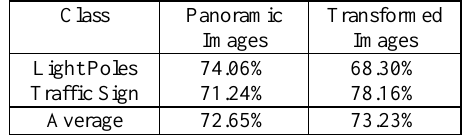
Table 1. Accuracy of the results from pre-trained FCN model.